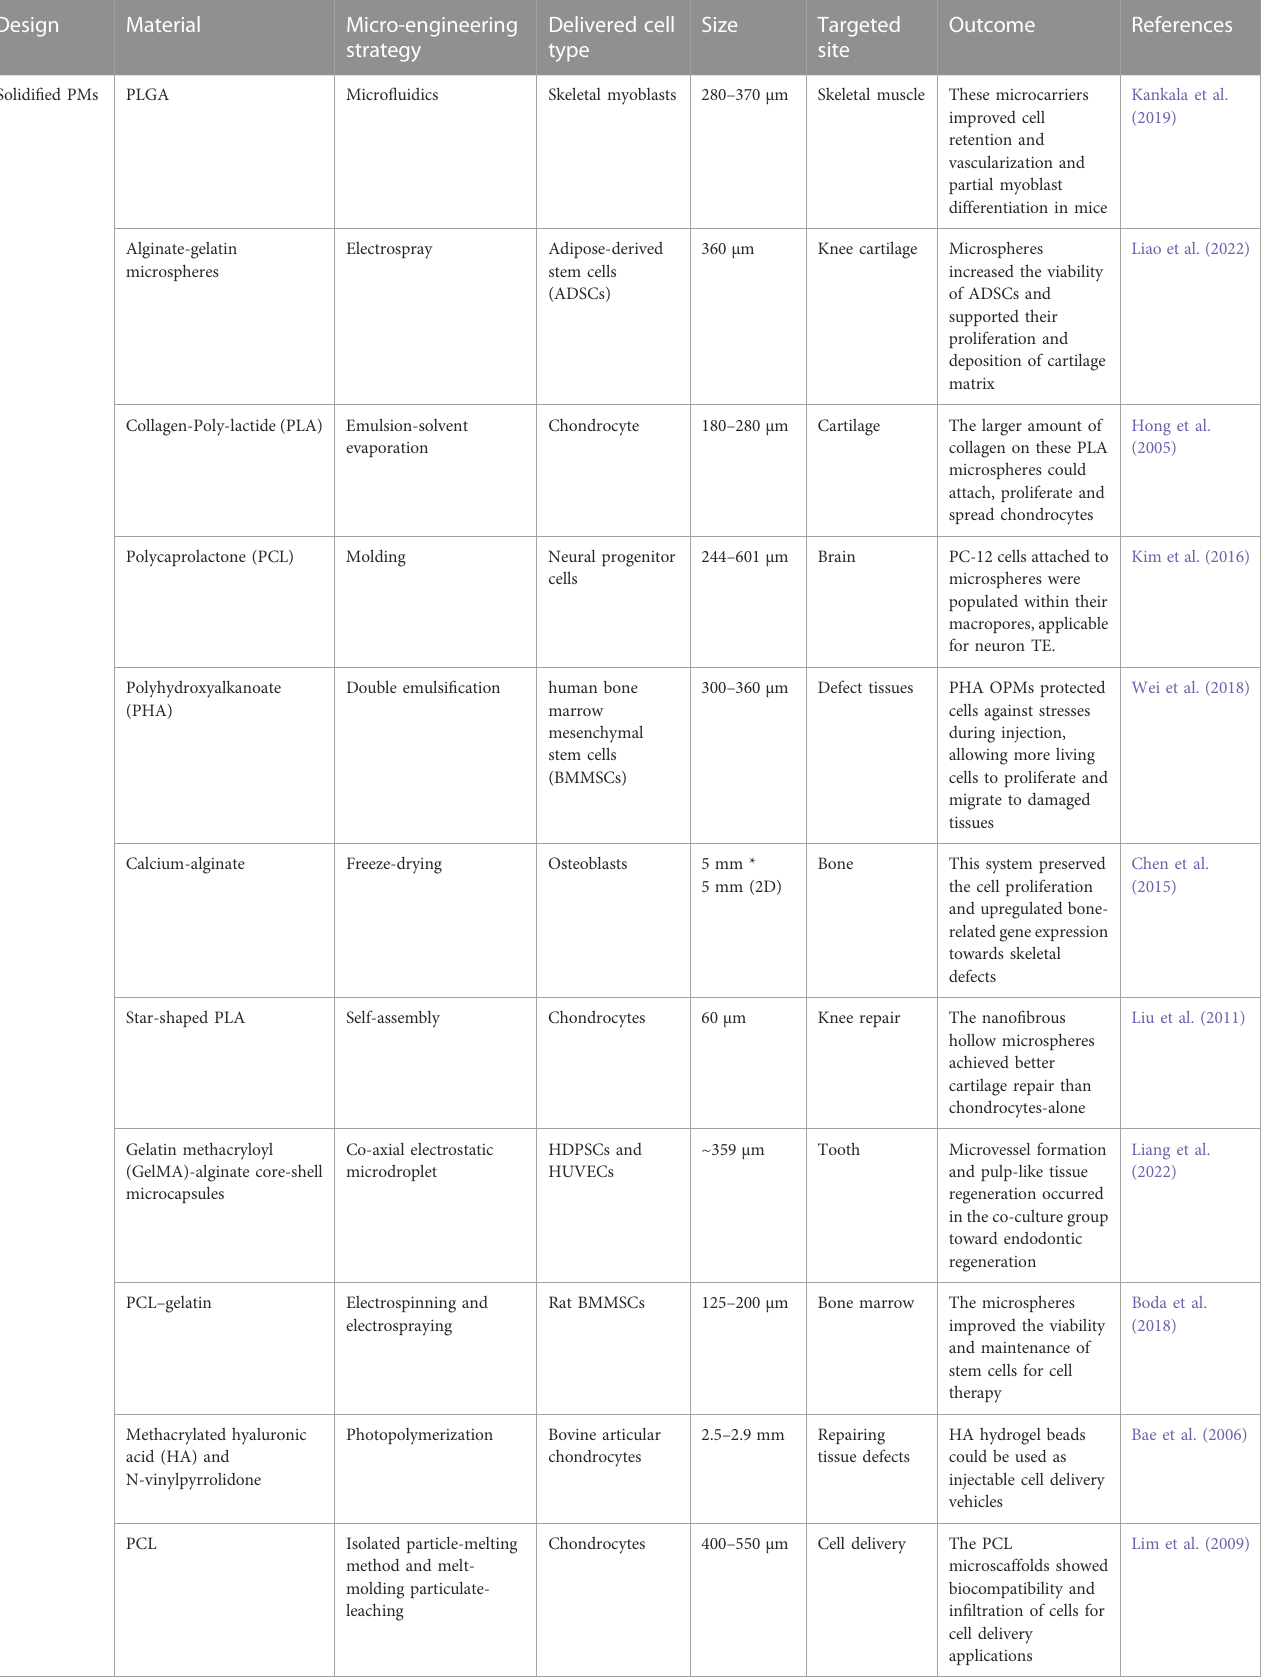
TABLE 1 Summary of various cell-laden carriers for minimally-invasive delivery of cells for tissue repair and regeneration